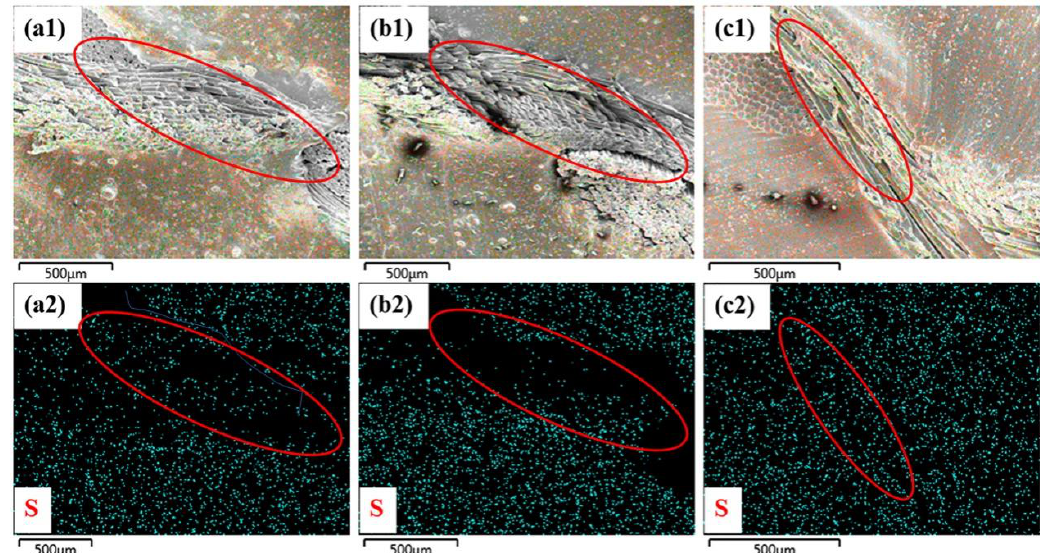
Figure 8. ( a1 – c1 ) EDS images of PET fabric/rubber composite cross-sections treated by GTL, ETL and RFL. ( a2 – c2 ) Sulfur element distribution on cross-sections of PET fabric/rubber composites treated with GTL, ETL and RFL impregnation solutions.